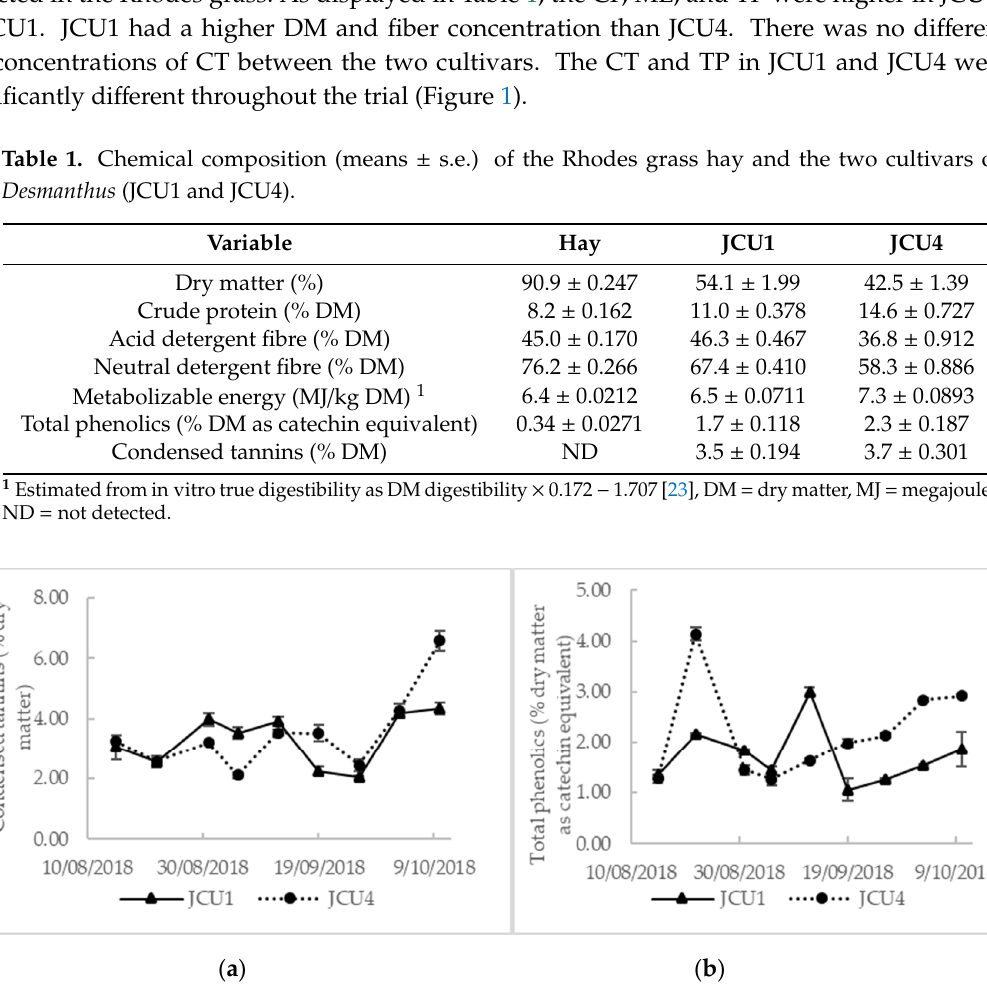
Figure 1. Variation in ( a ) condensed tannins (% dry matter) and ( b ) total phenolics (% dry matter as catechin equivalent) throughout the feeding period.